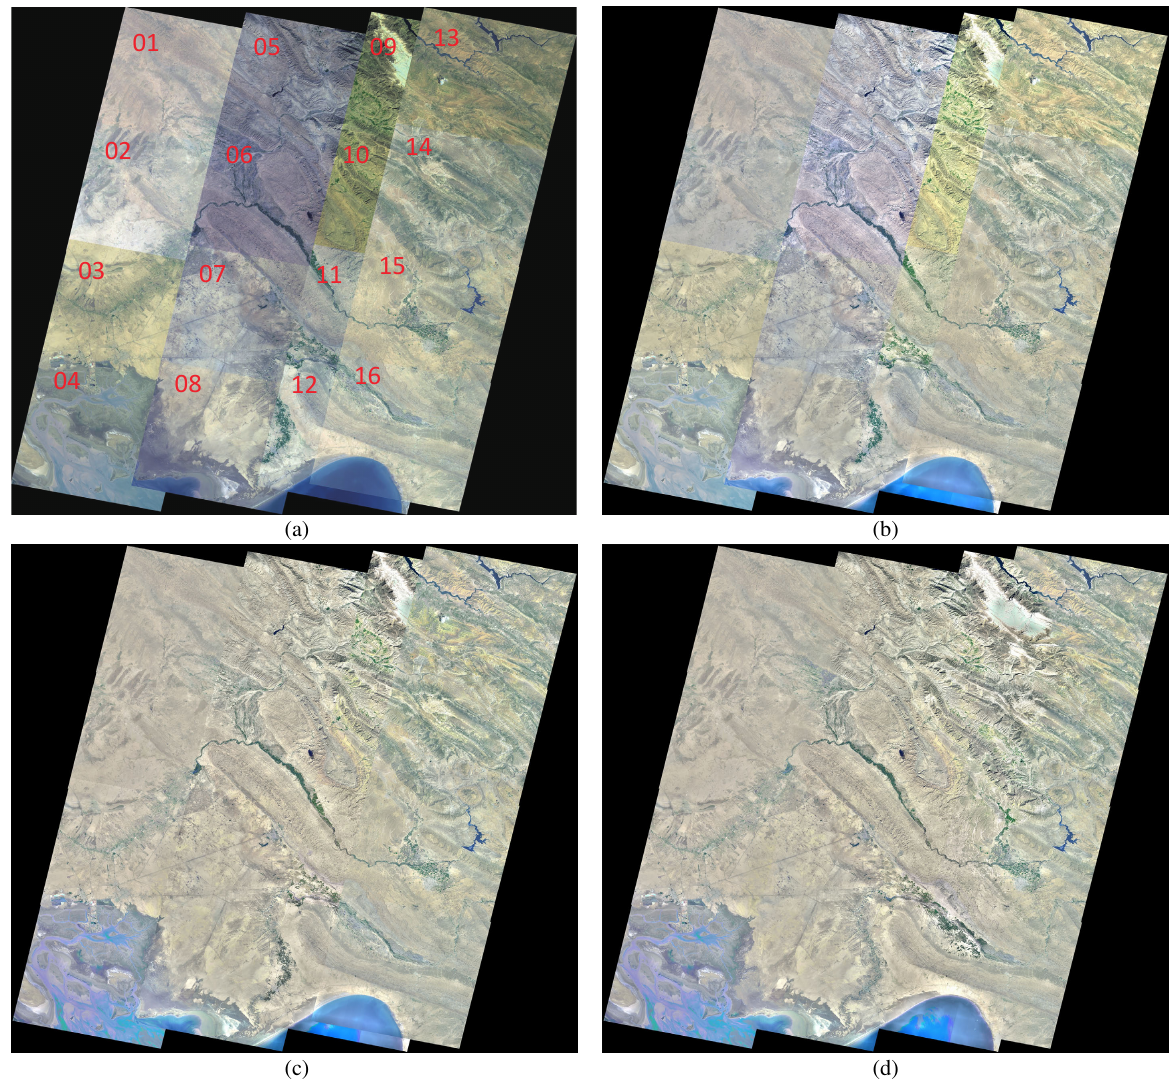
Figure 10. The experimental results on four strips of multi-temporal images: (a) the mosaicked image by a simple superposition from 16 input images; (b) the transferred results via tonal preprocessing, with a basically consistent luminance; (c) the finally corrected results based on the maximum reference subset { 14 ; 15 ; 16 } ; (d) the mosaicked image by applying a multi-band blending on the finally corrected images in (c) with the open source software Enblend